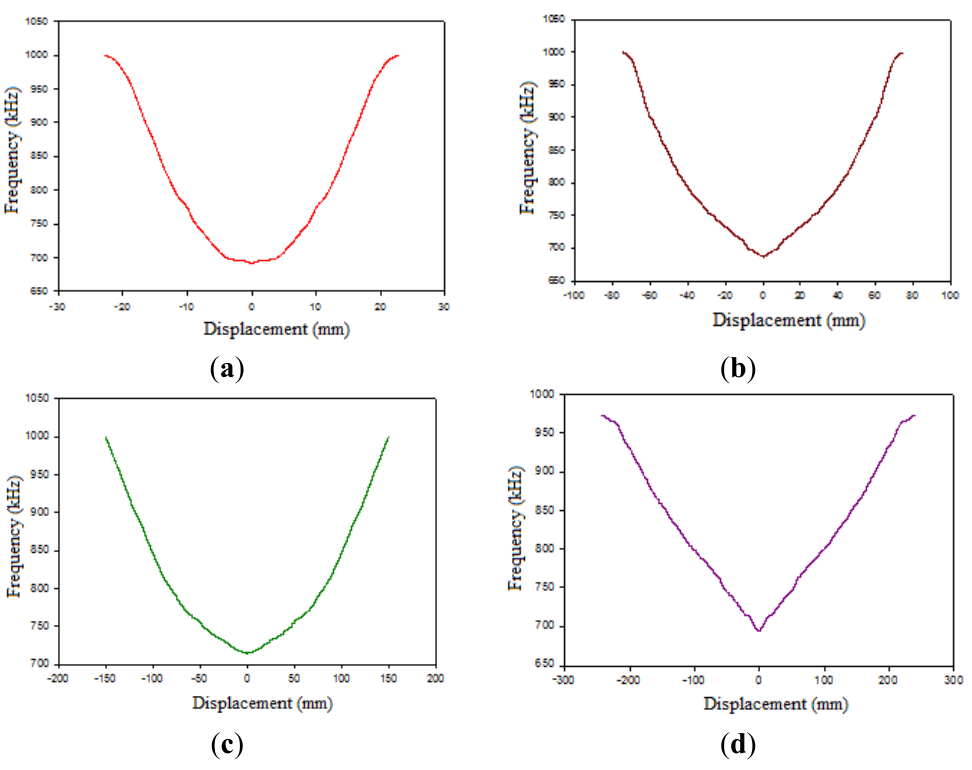
Figure 5. Calibration curve of coils with metallic glass as core and different